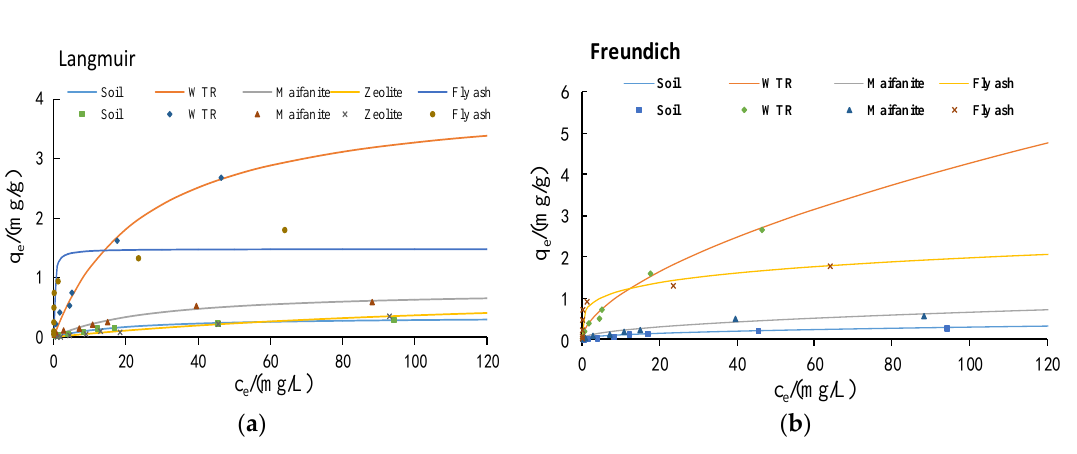
Figure 3. Adsorption characteristic curves of single filler. Curves are fitted ( a ) Langmuir isotherms and ( b ) Freundich isotherms. Table 4. Isothermal adsorption equations and related parameters.